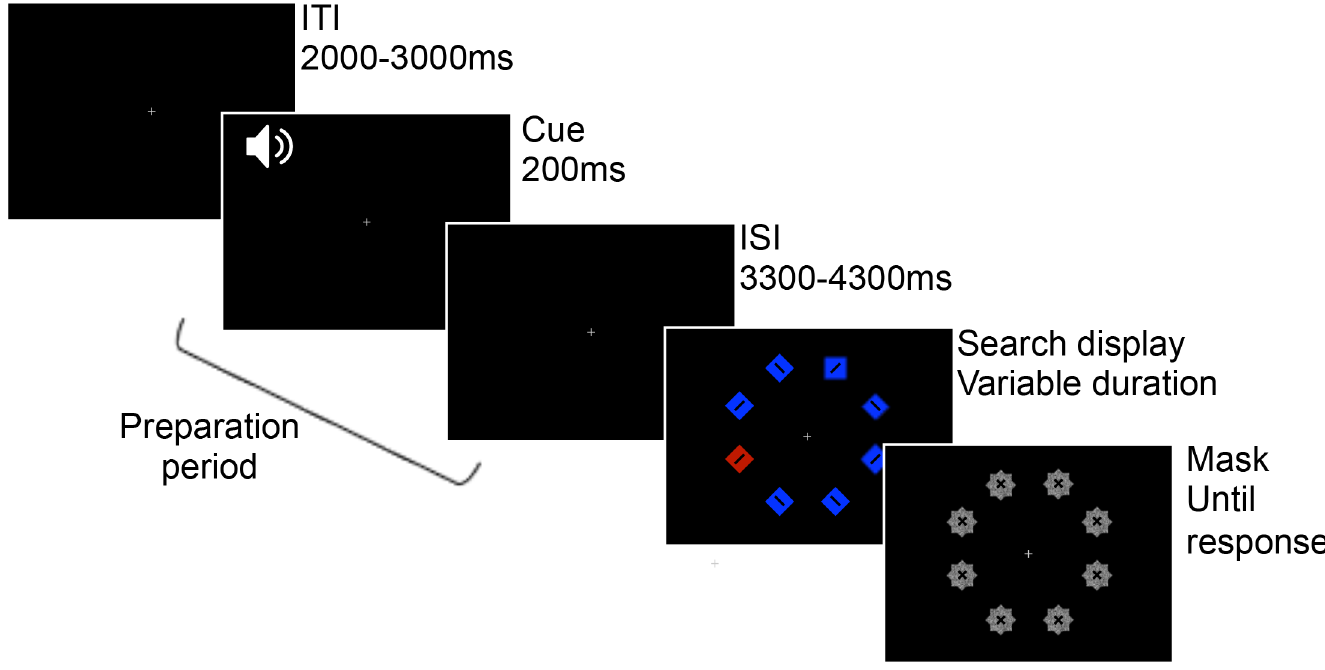
Fig 4. Experiment 2 trial